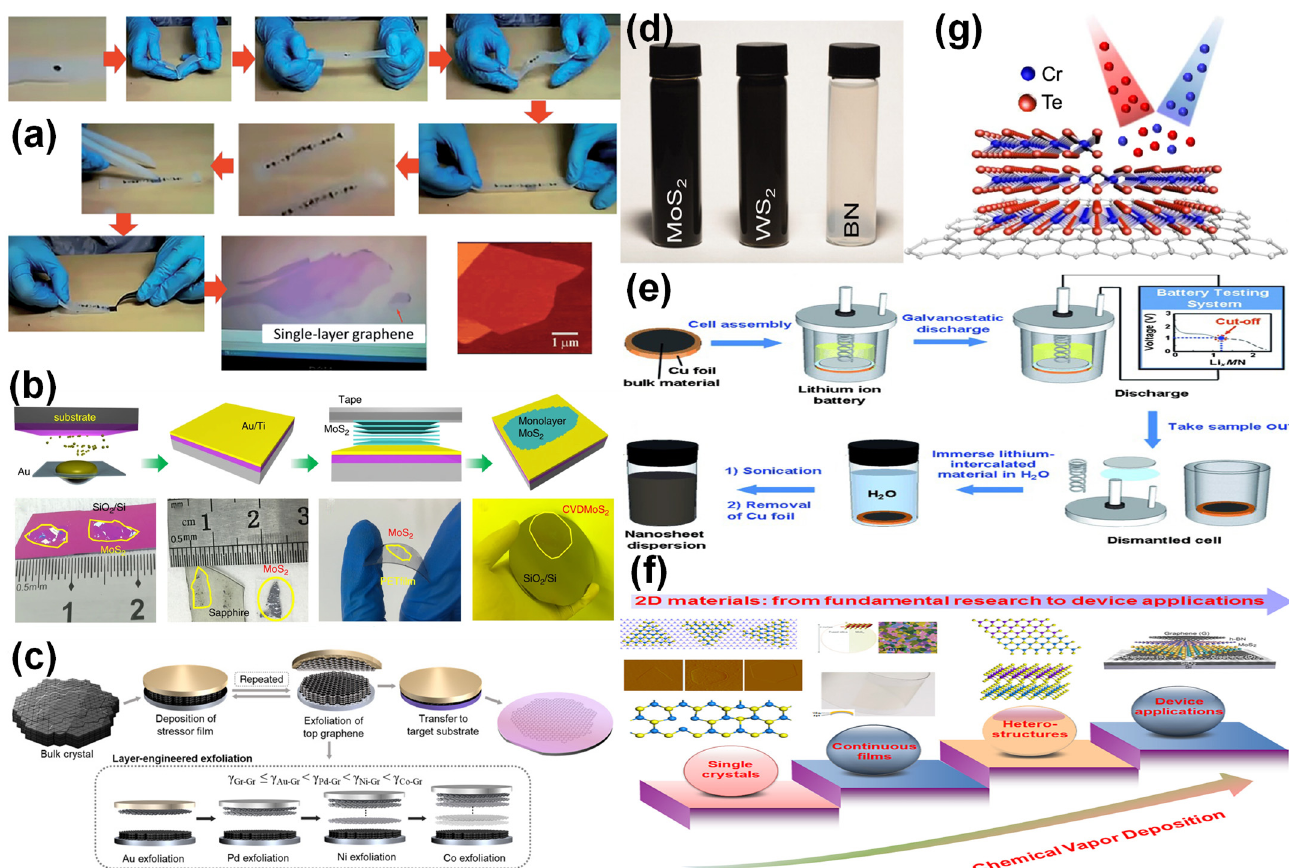
Figure 8. ( a ) Illustrative procedure of the micromechanical cleavage of graphene based on transparent tape. Reused with permission from [178] . ( b ) Schematic of the exfoliation process assisted by an Au adhesive. Reused with permission from [179] . ( c ) Schematic illustration of the LEE large-area graphene exfoliation technique. Reused with permission from [180] . ( d ) Photographs of the dispersions of MoS 2 (in N-methyl-pyrrolidone (NMP)), WS 2 (in N-methyl-pyrrolidone (NMP)), and BN (in isopropanol (IPA)). Reused with permission from [181] . ( e ) The electrochemical lithium intercalation process is used to produce 2D nanosheets from the layered bulk material. Reused with permission from [182] . ( f ) Overview of the CVD growth of 2D materials, from single crystals to continuous films, and further to 2D-material-based heterostructures, as well as their device applications. Reused with permission from [184] . ( g ) Illustration of MBE growth process of CrTe 2 films on graphene. Reused with permission from [60] .